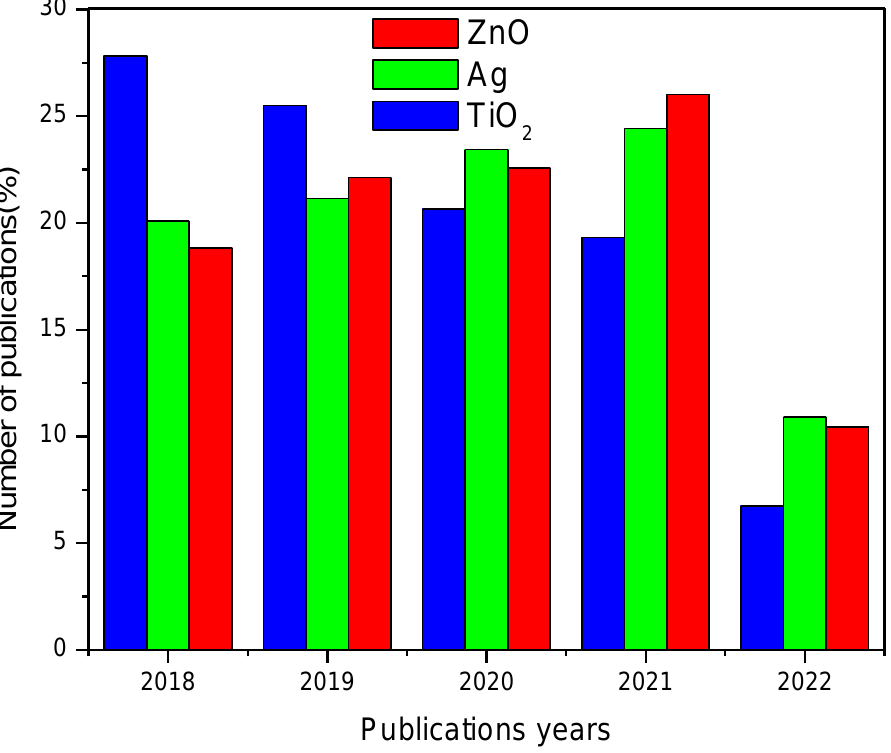
Figure 1. Number of publications on photocatalytic activity of ZnO, Ag, and TiO 2 from 2018 to 2022. As of 7 July 2022.